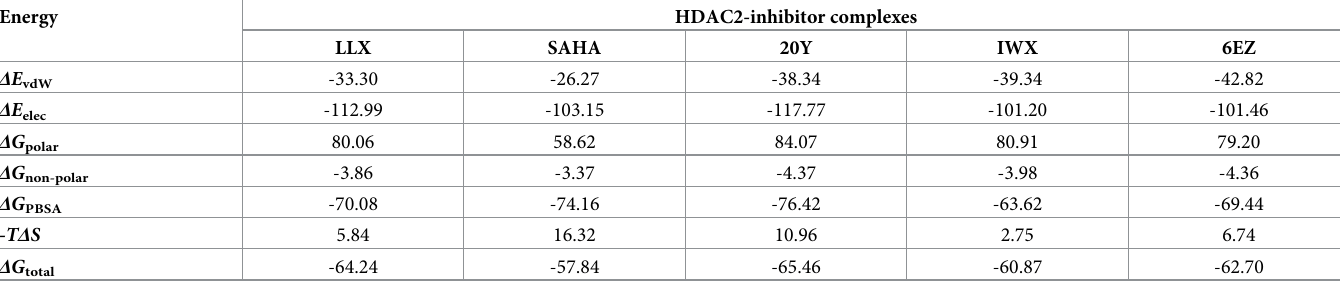
Table 1. Binding free energy of complexes between HDAC2 and known HDAC2 inhibitors based on 100-ns MD simulations and MM-PBSA calculations. The entropic contributions were calculated using the quasi-harmonic (QH) approximation. All values are presented in kcal/mol.